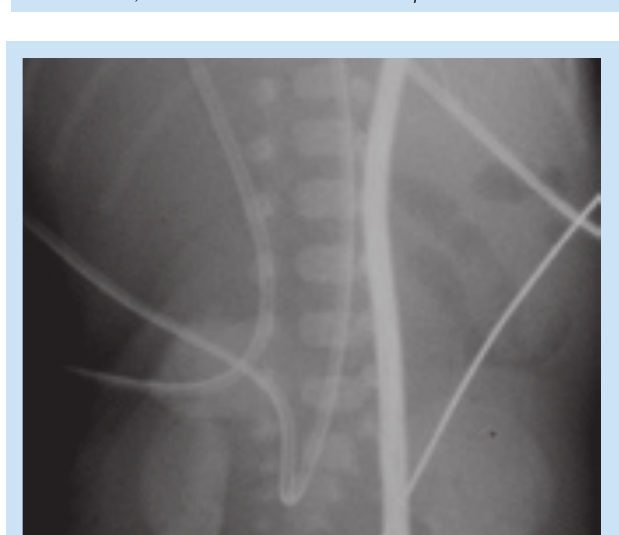
Fig. 5. Identification of lines and tubes. • A UAC takes a course inferiorly first to enter the internal iliac artery and then should have its tip above the level of the coeliac trunk and below the ductus arteriosus to the left of the